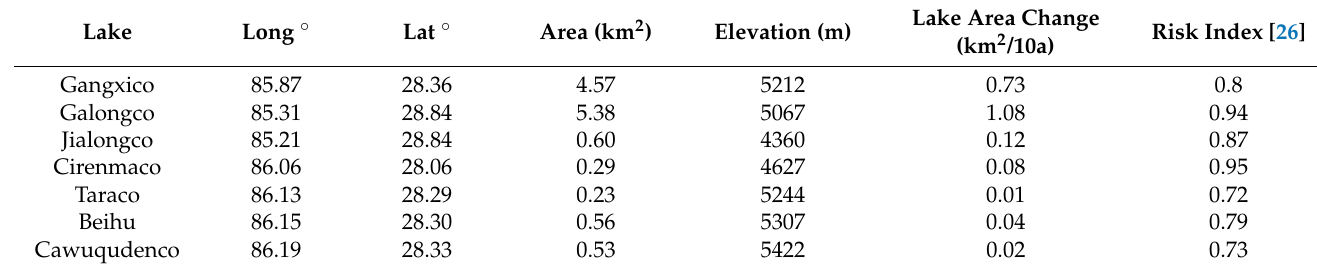
Table 1. Summary of potentially dangerous glacial lakes.